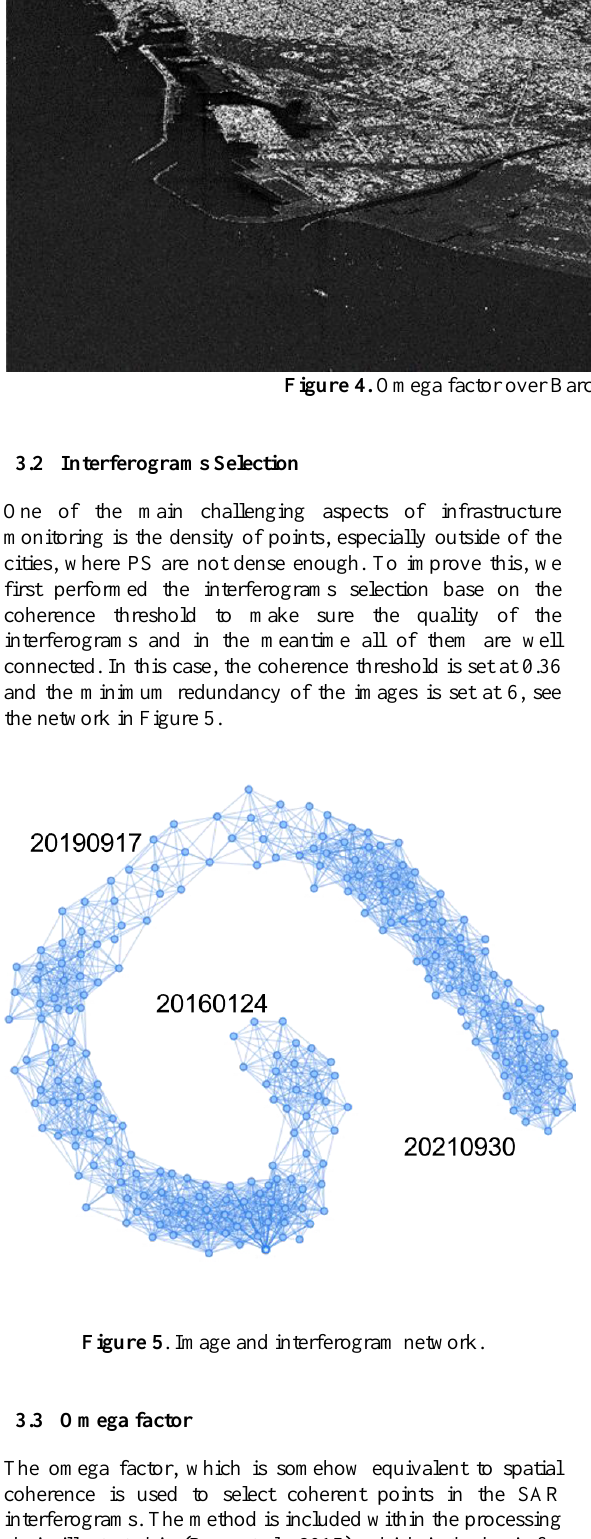
Figure 6 . Displacement velocity map over railway network in